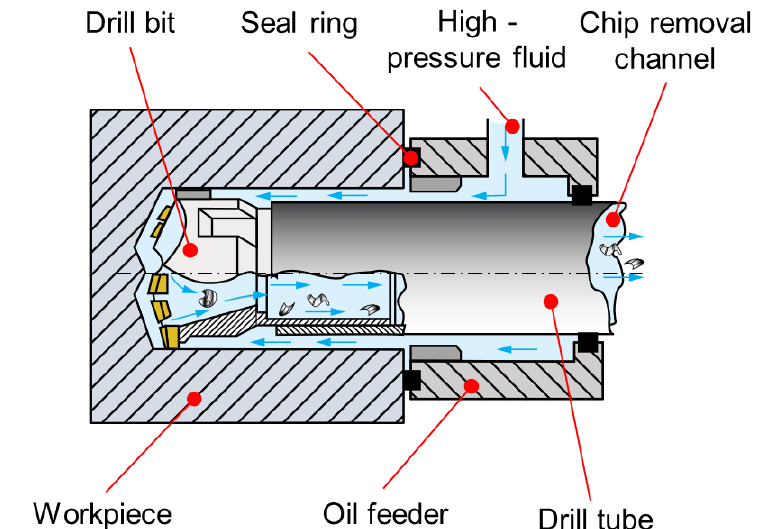
Figure 1. Schematic diagram of the BTA system.